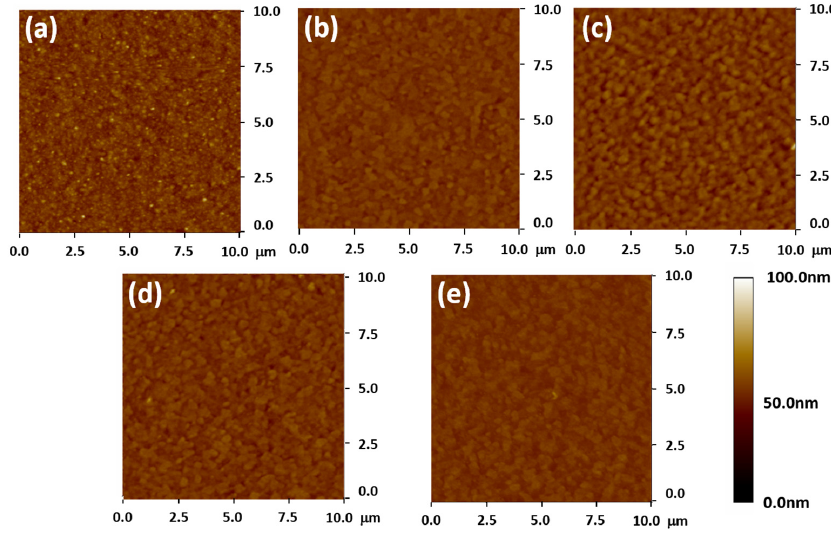
Figure 5. AFM images of the ZnO electron transport layer (~20 nm) with different baking temperatures: ( a ) 100 °C; ( b ) 120 °C; ( c ) 150 °C; ( d ) 180 °C; and ( e ) 250 °C.